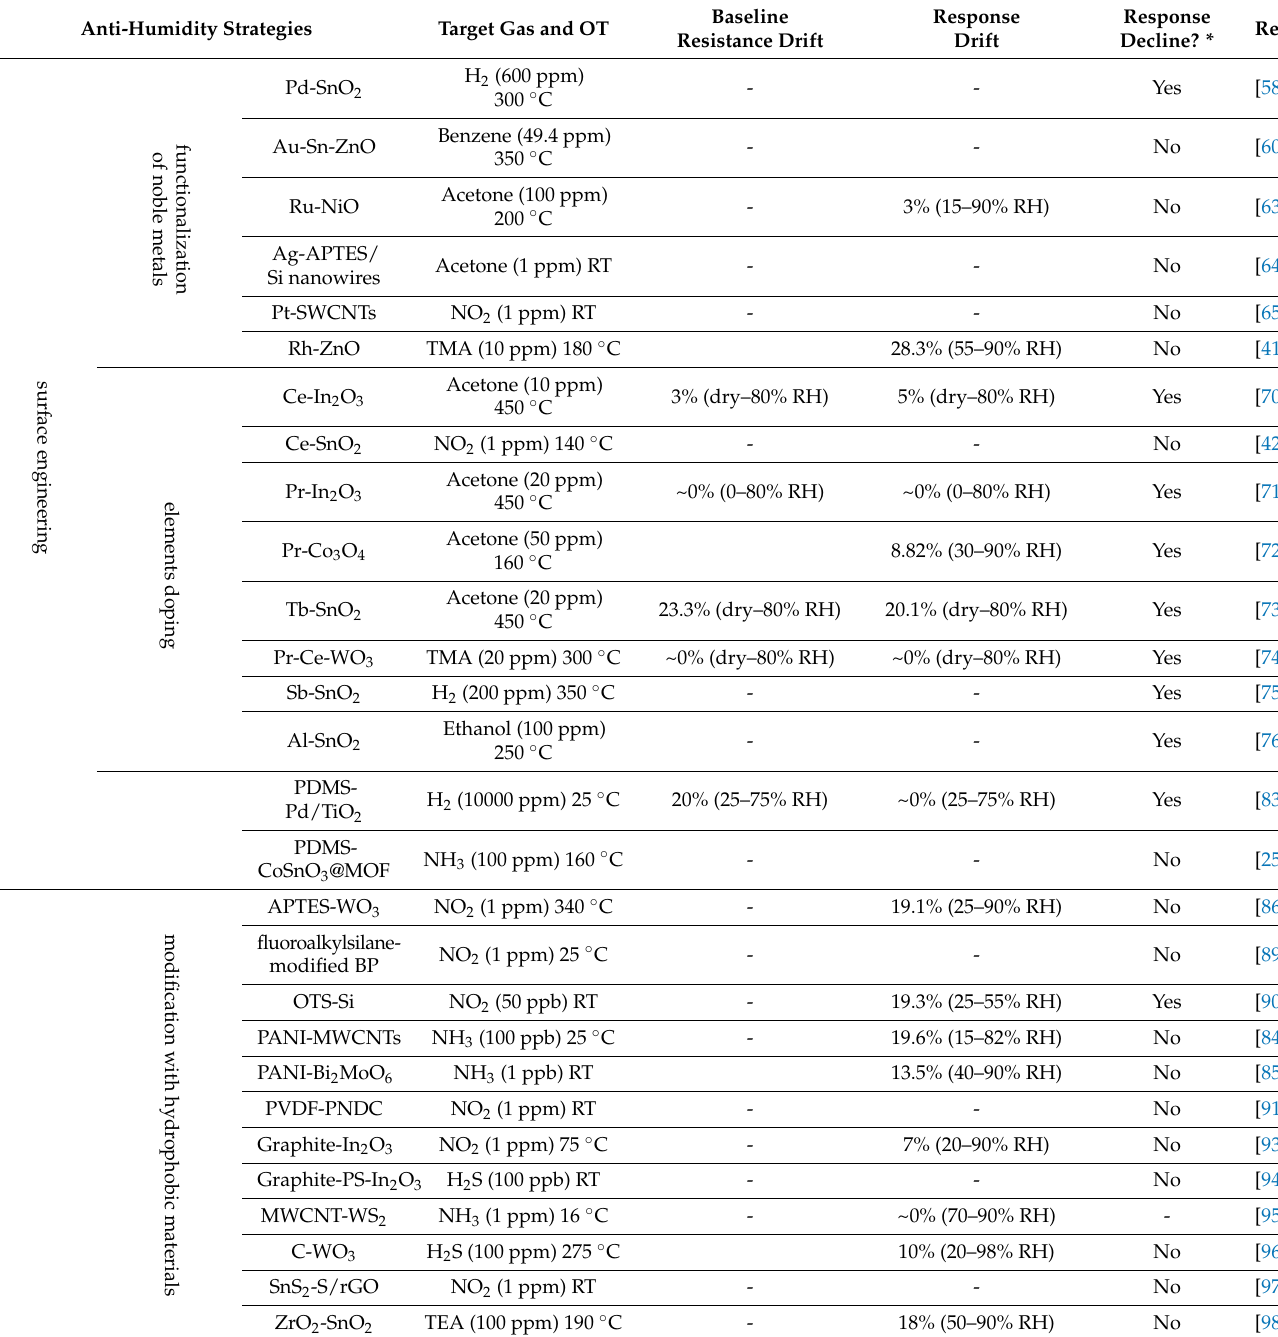
Table 1. The anti-humidity performances of recently-reported gas sensors. Anti-Humidity Strategies Target Gas and OT